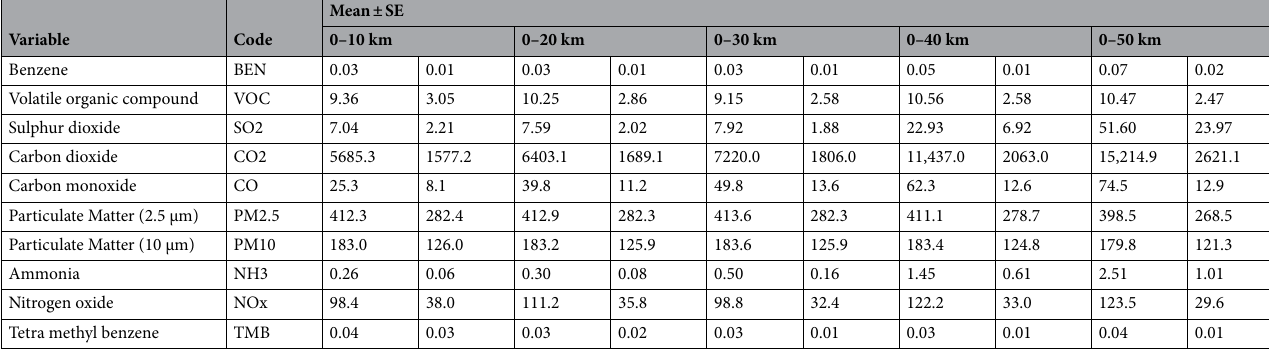
Table 1. Summary of the emission rates (ton/year) of particulates and gases from anthropogenic sources estimated at different spatial scales (see main